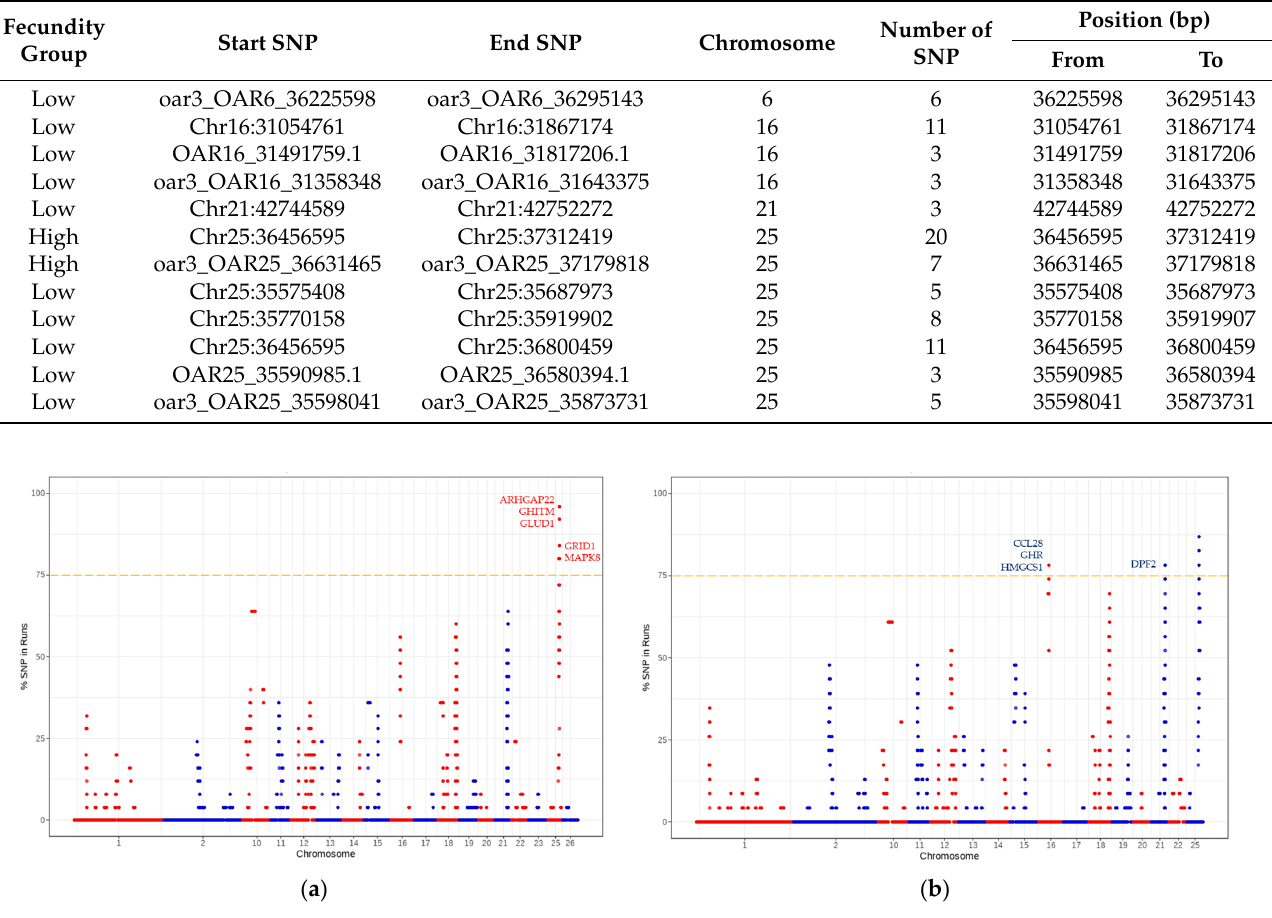
Figure 2. Genomic distribution of positive selection signatures for high ( a ) and low ( b ) fecundity using the frequency of SNP in the different ROH haplotypes in Katahdin ewes. The yellow dotted line indicates the minimum frequency required to consider ROH/SNP as candidates (75%).